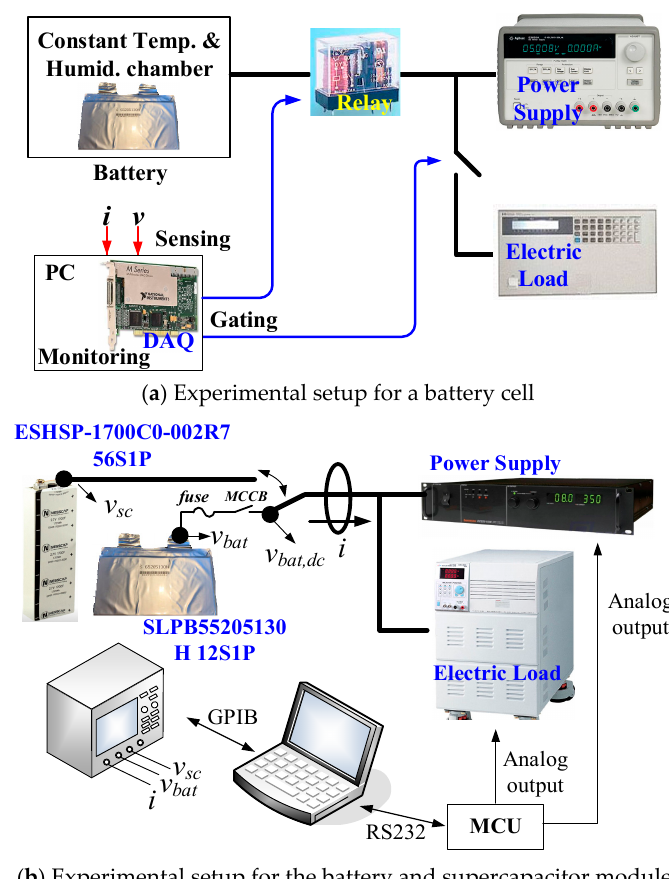
Figure 6. Experimental configuration of the battery and supercapacitor. Table 1. Specifications used for experimental testing.